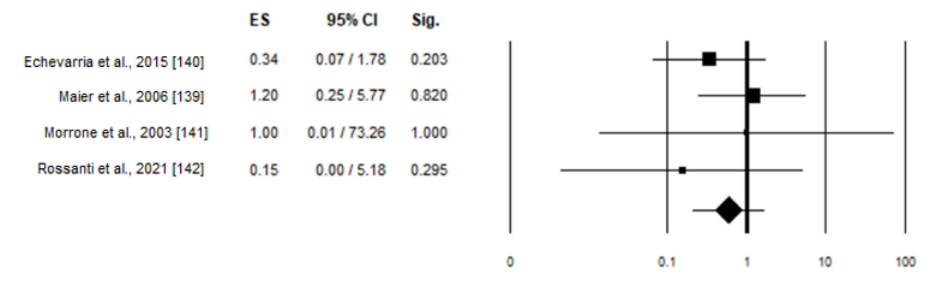
Figure 5. Forest plots for skewed versus random XCI in symptomatic Fabry carriers at cardiac level. Heterogeneity I 2 = 0.0%, p = 0.609.